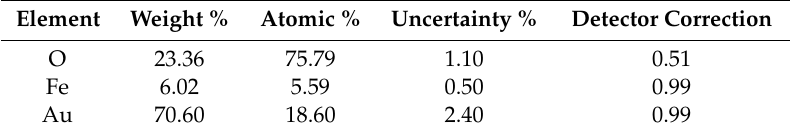
Table 4. Elemental analysis of gold coated commercial iron oxide nanoparticles.